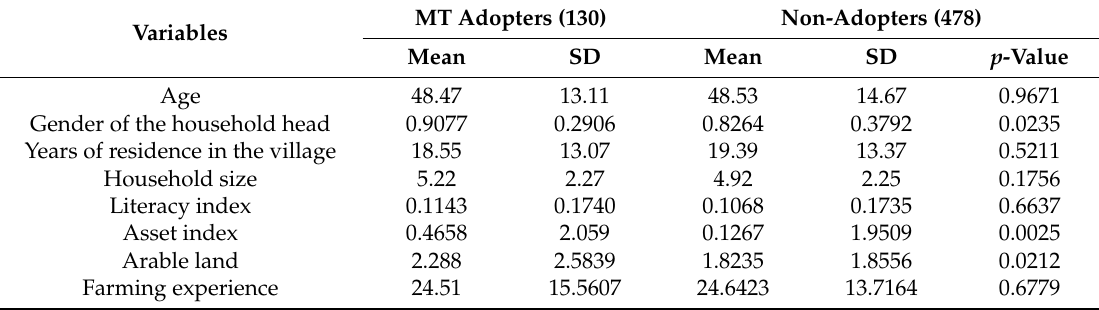
Table 1. Descriptive statistics of the household